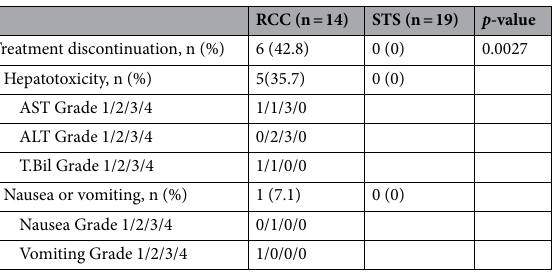
Table 4. Treatment discontinuation due to adverse events. Two-tailed Fisher’s exact test. RCC, renal cell carcinoma; STS, soft tissue